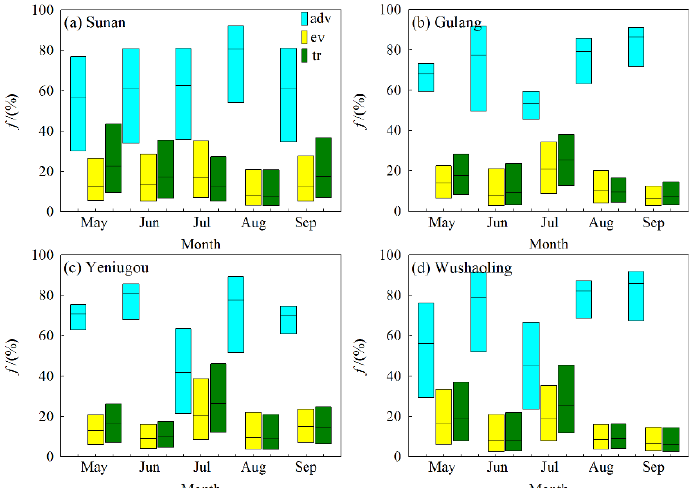
Figure 3. Box plot of monthly percent contributions of the three water vapor-to-precipitation methods. In the box plot, the rectangles span the first quartile to the third quartile, and the segment inside the rectangle shows the median value, ( a – d ) represents Sunan, Gulang, Yeniugou and Wushaoling, respectively.